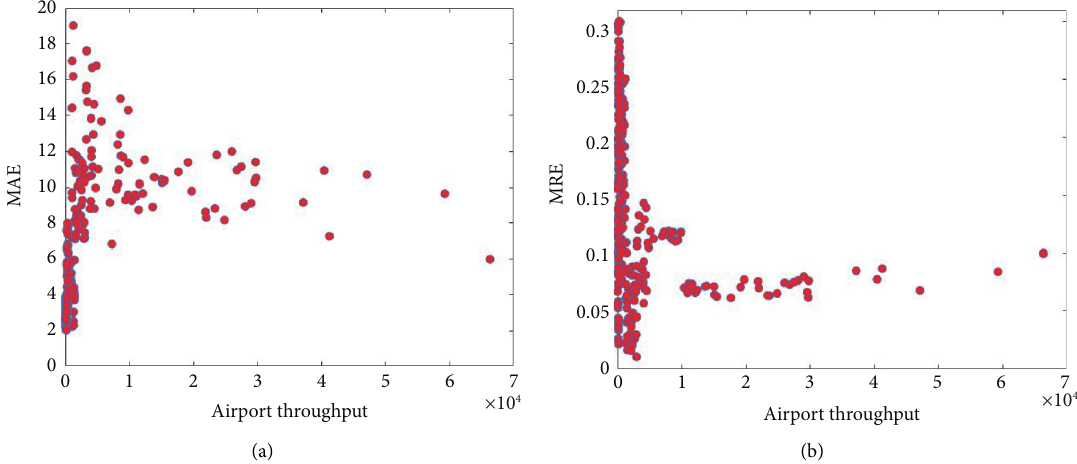
Figure 8: Relationship between the forecast error and the flight